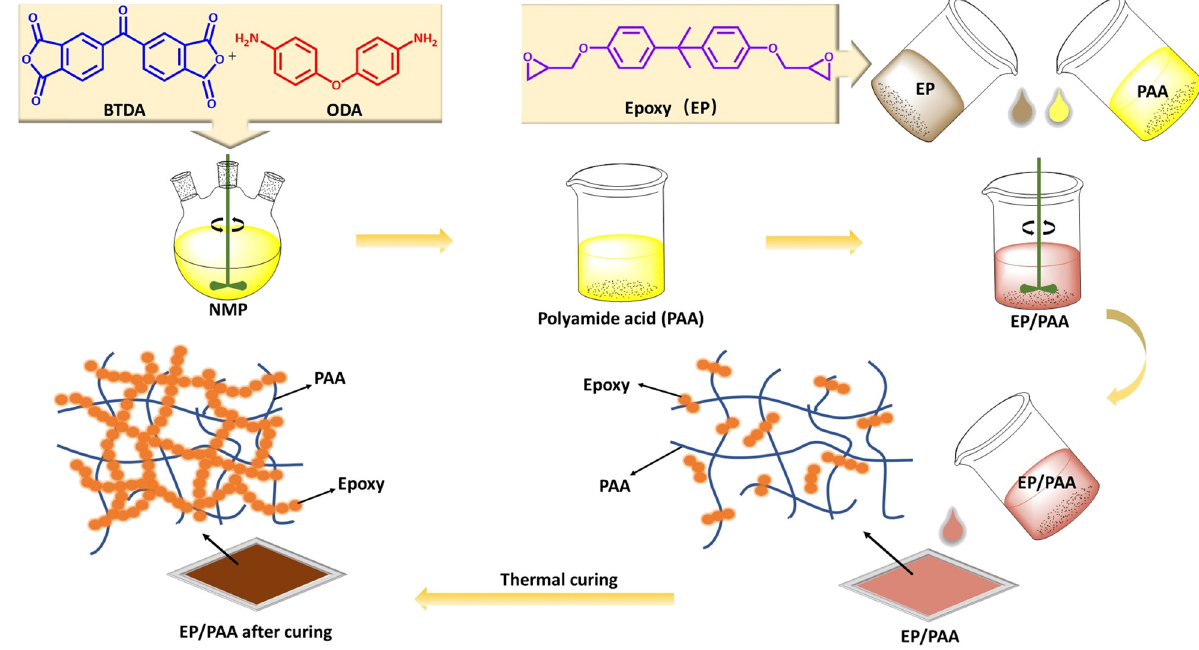
Figure 1: The reaction scheme for the epoxy resin modi fi ed by PAA.